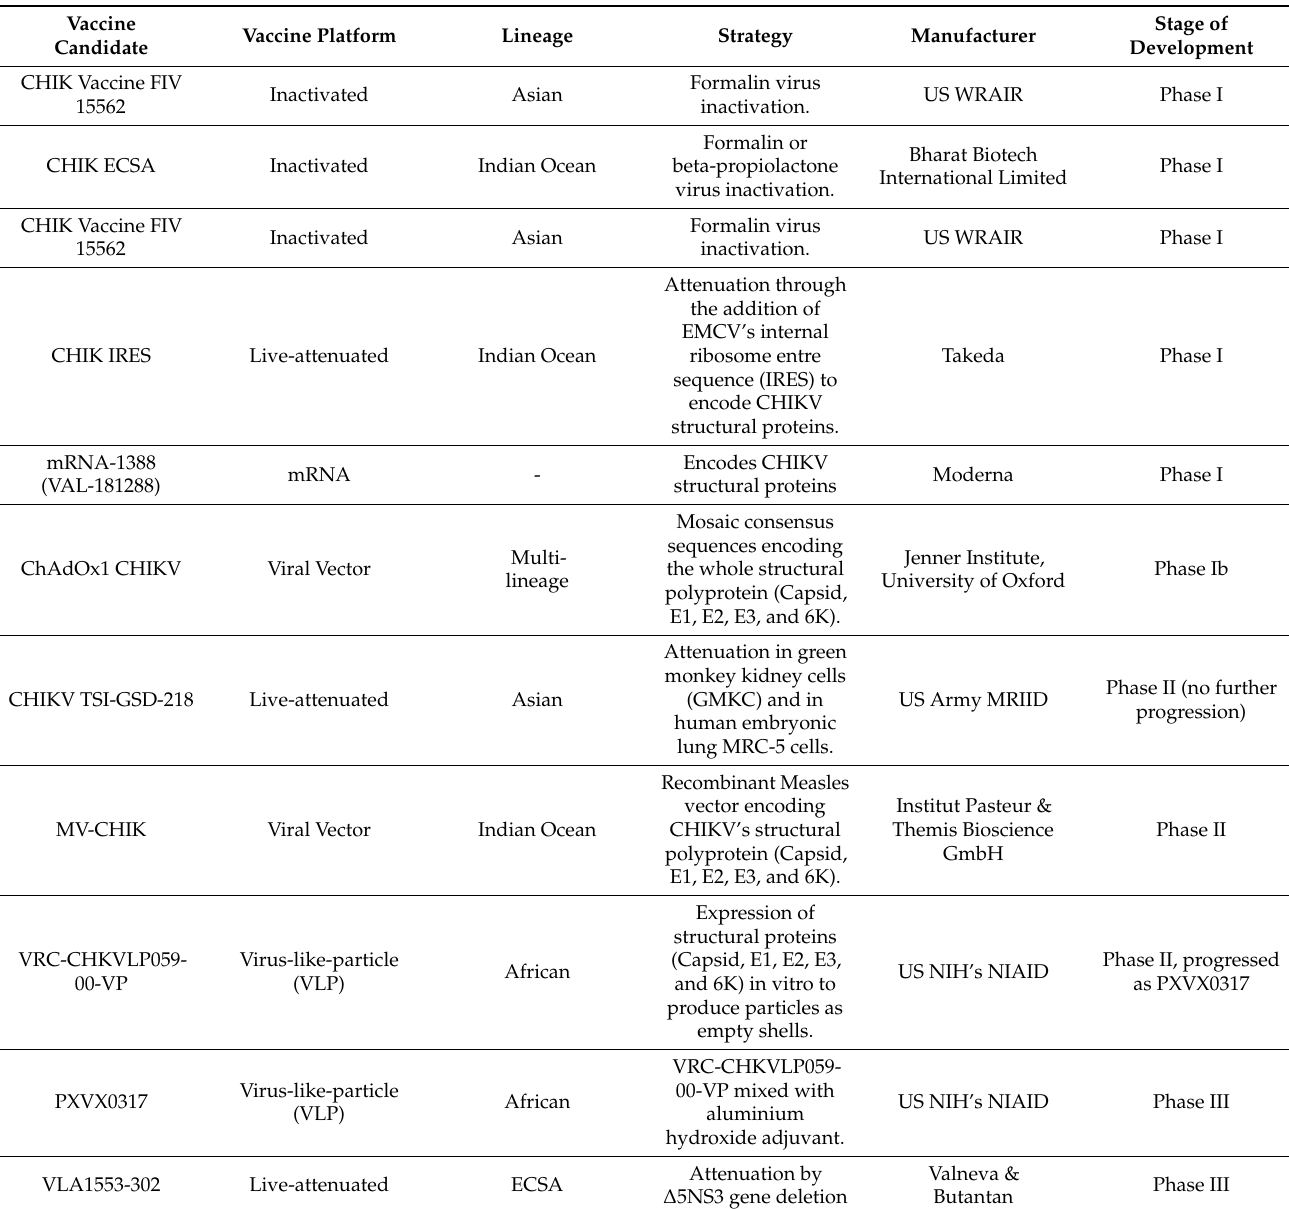
Table 1. General features of CHIKV vaccines that have entered clinical trials (Phase